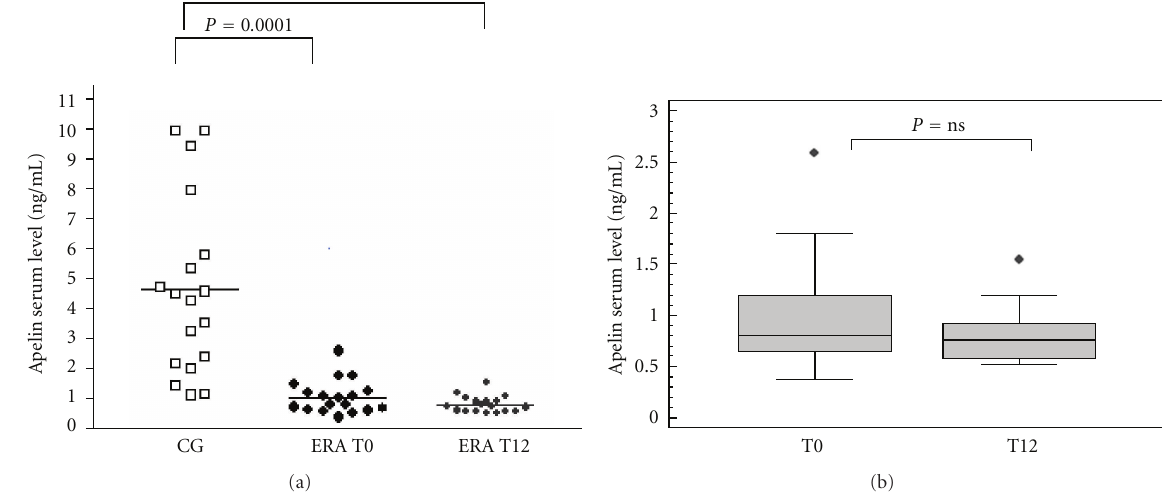
Figure 2: Apelin serum levels in ERA patients and controls (a) and in ERA patients before and after treatment